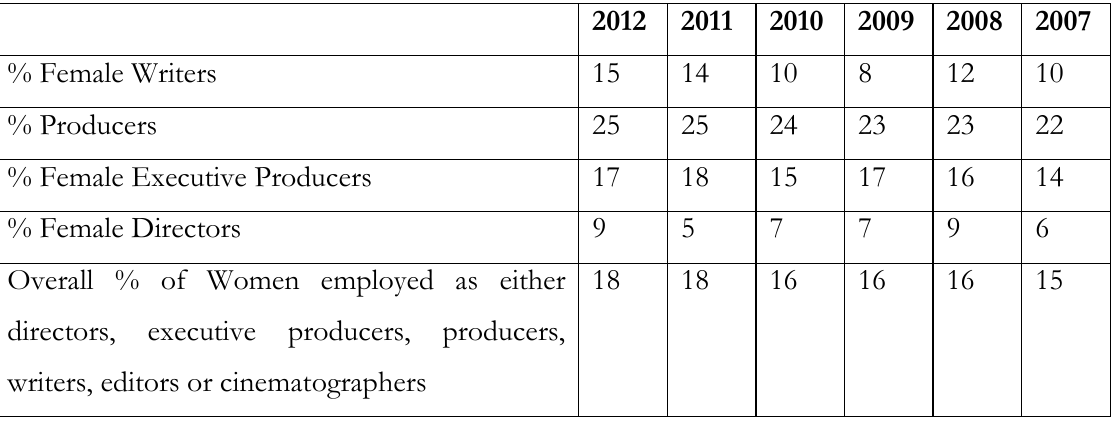
Historical Comparison of Percentages of Women Employed in Key Behind-the-scene Roles taken from Martha M Lauzen’s Celluloid Ceiling reports on the Top 250 Films of